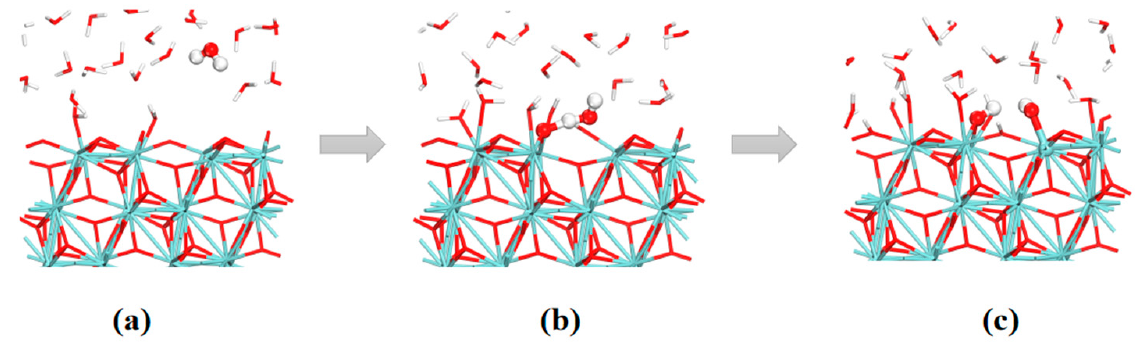
Figure 8. FPMD simulation snapshots at 0 ( a ), 1000 ( b ) and 3000 fs ( c ) of the water–solid interface reaction of ZrO 2 at site A .